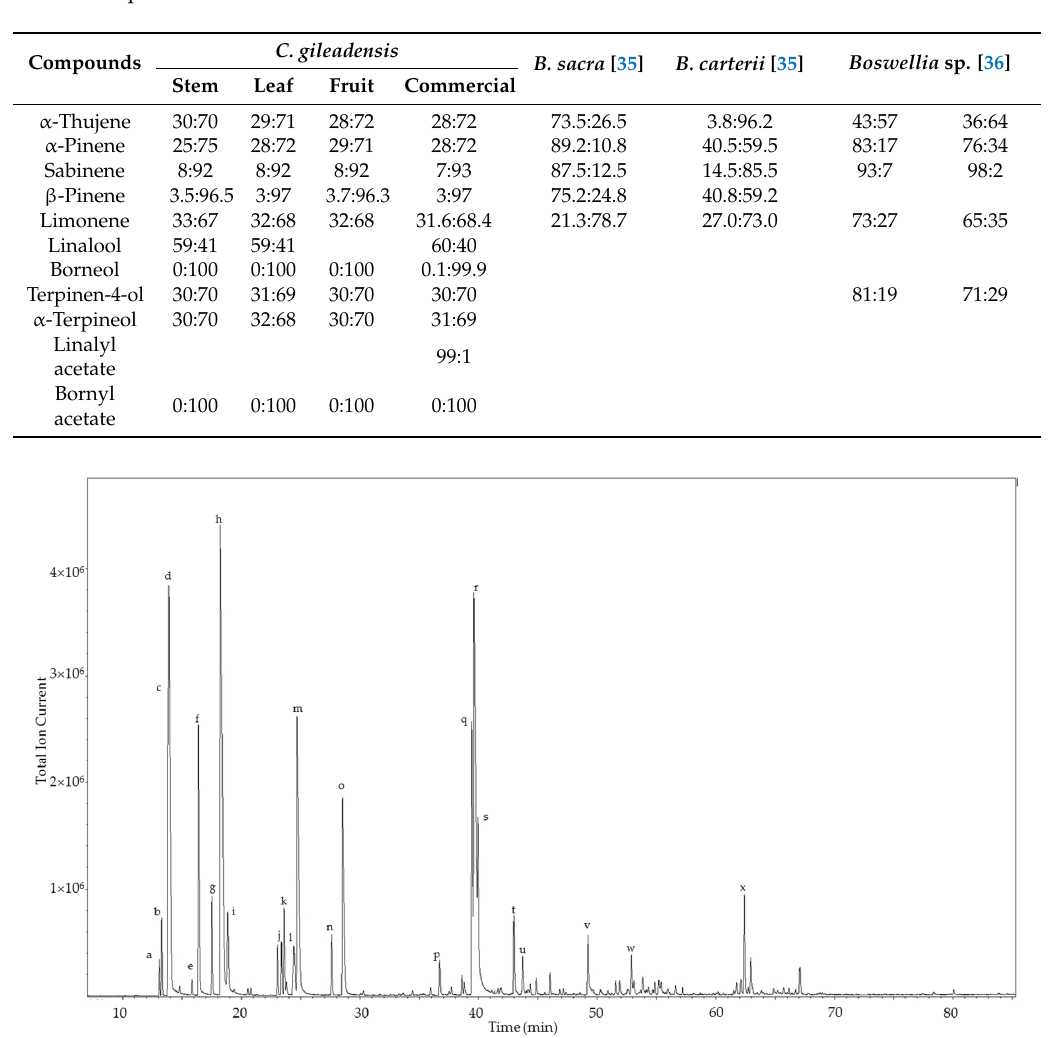
Figure 2. Chiral gas chromatogram of the leaf essential oil of Commiphora gileadensis . The major components are indicated: a, (+) ‐α‐ thujene; b, ( − ) ‐α‐ thujene; c, (+) ‐α‐ pinene; d, ( − ) ‐α‐ pinene; e, (+) ‐β‐ pinene; f, ( − ) ‐β‐ pinene; g, (+) ‐ sabinene; h, ( − ) ‐ sabinene; i, myrcene; j, (+) ‐ limonene; k, α‐ terpinene; l, ( − ) ‐ limonene; m, p ‐ cymene; n, terpinolene; o, γ‐ terpinene; p, ( − ) ‐ borneol; q, (+) ‐ terpinen ‐ 4 ‐ ol; r, ( − ) ‐ terpinen ‐ 4 ‐ ol; s, ( − ) ‐ bornyl acetate; t, ( − ) ‐α‐ terpineol; u, (+) ‐α‐ terpineol; v, ( E ) ‐ caryophyllene; w, germacrene D; x, 1,10 ‐ di ‐ epi ‐ cubenol.